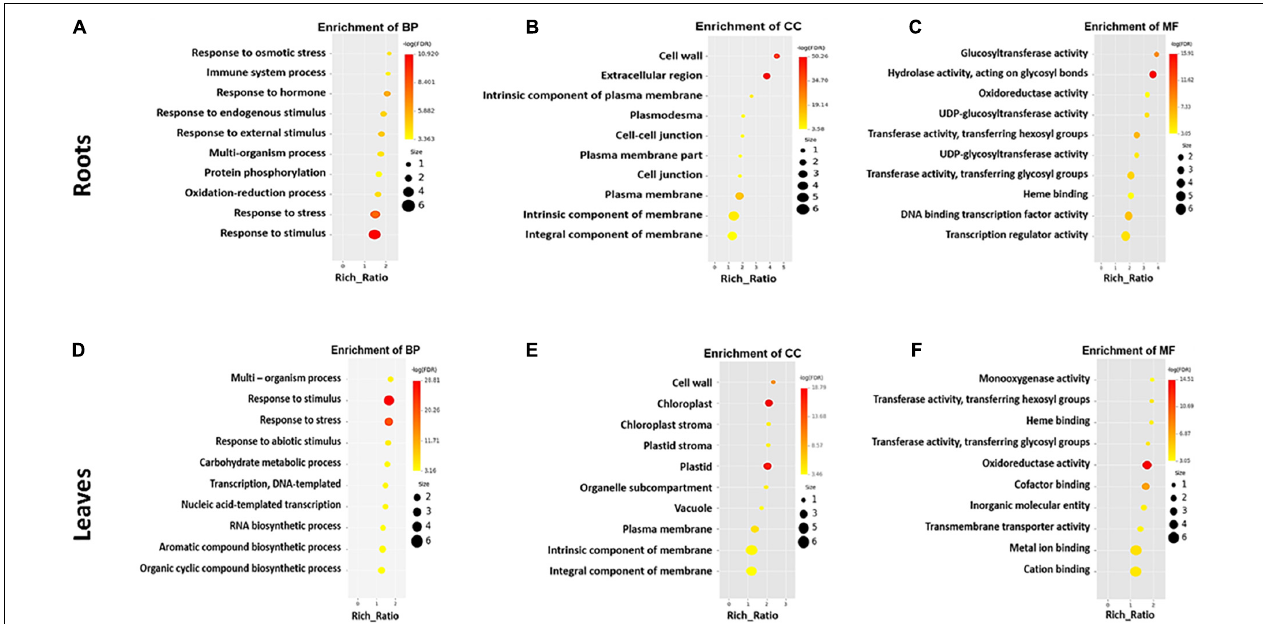
FIGURE 4 | The most enriched GO terms in different categories viz., biological process (A) , cellular component (B) , and molecular function (C) in the roots, whereas biological process (D) , cellular component (E) , and molecular function (F) in the leaves of S. argel plants are exposed to salt stress.